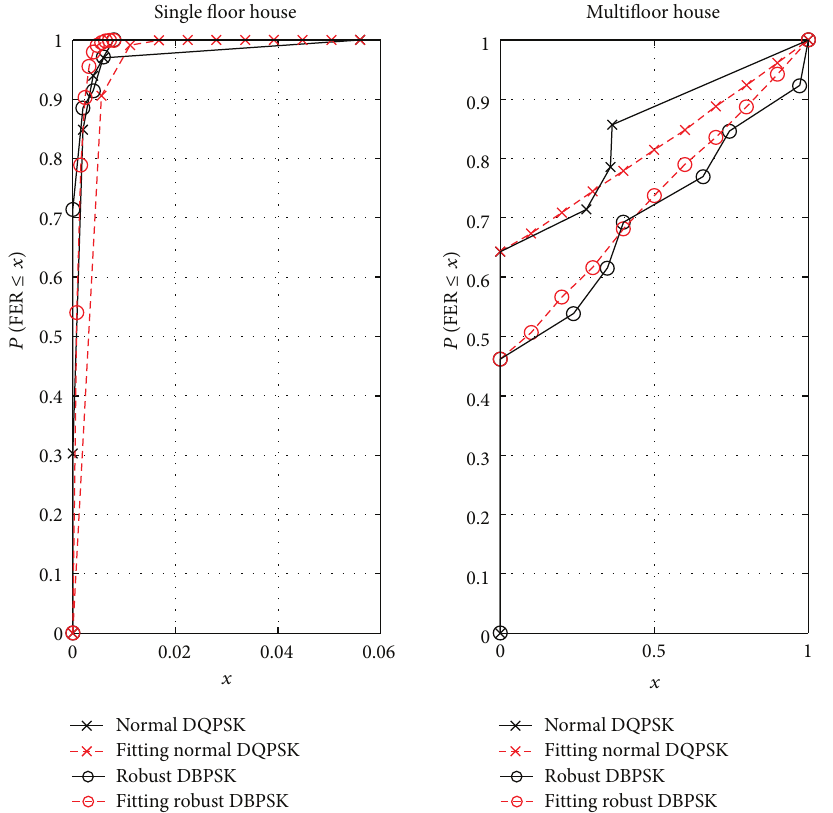
F 7: CDF of the measured FER for G3-PLC technology. e distribution �tting is also shown.